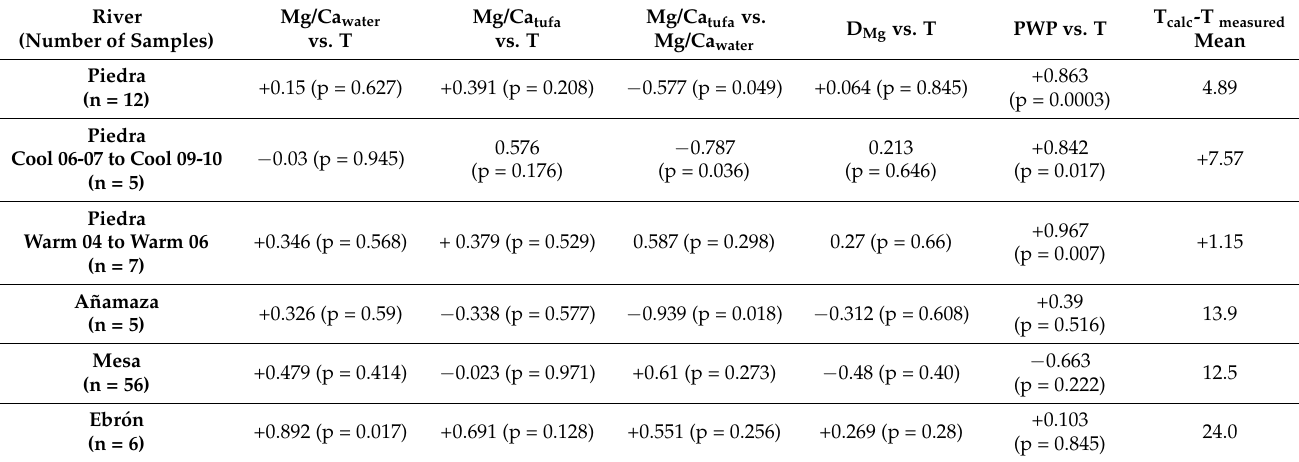
Table 2. Correlations between some analytical parameters of studied tufa